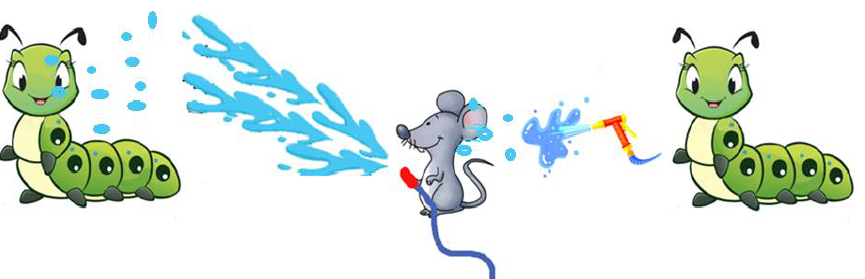
Figure 1. Example of images used to assess comprehension of object relative clauses with a 3 rd -person pronoun subject.